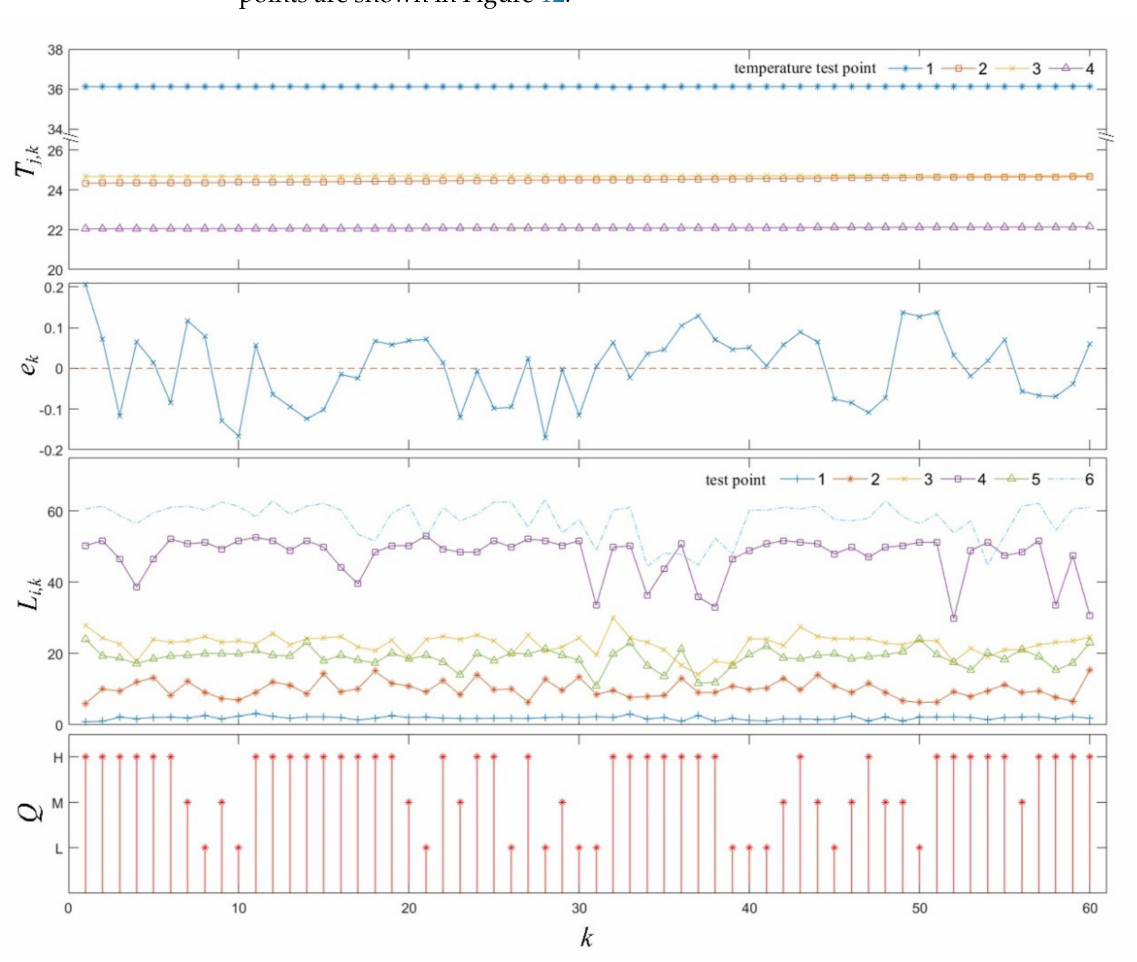
Figure 12. Data of 60 cladding